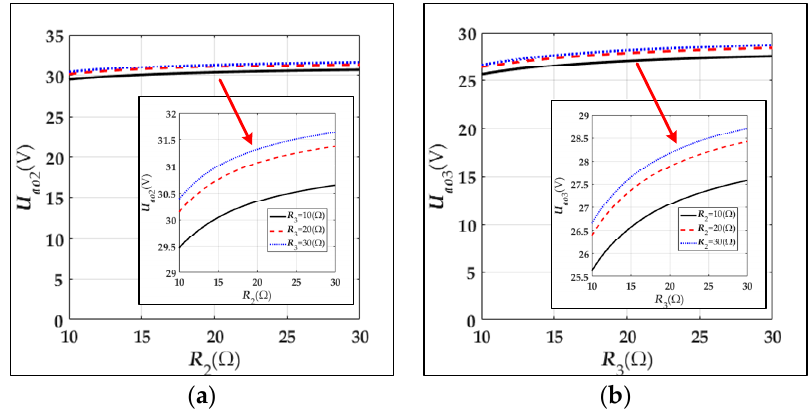
Figure 4. The variation of the output voltages with the loads in Mode A. ( a ) The variation of U ao 2 with R 2 and R 3 ; ( b ) the variation of U ao 3 with R 2 and R 3 .